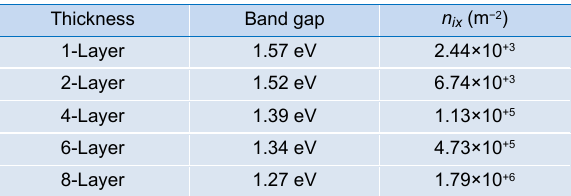
Table 3 | The intrinsic carrier concentration ( k x ) of SnS 2 vs. the number of SnS 2